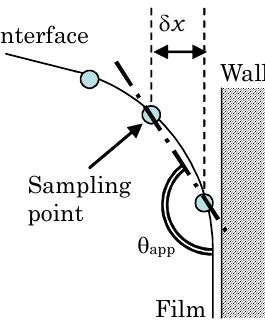
Fig. A1 Derivation of apparent